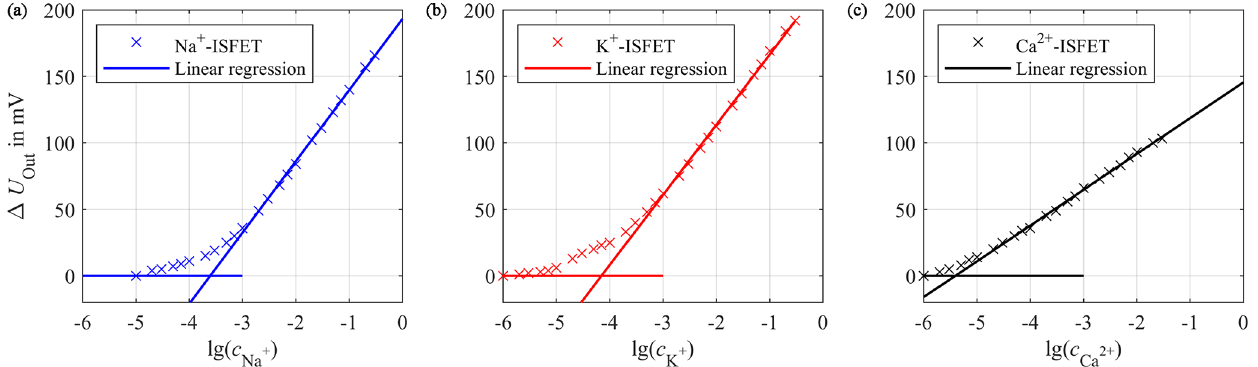
Figure 10. Calibration curve of the sodium ISFET (a) , potassium ISFET (b) and calcium ISFET (c) with linear regressions for high concen- trations to calculate the sensitivities. The concentration c is given in molL − 1 . Table 2. Characterized parameters of sodium, potassium and calcium ISFETs.